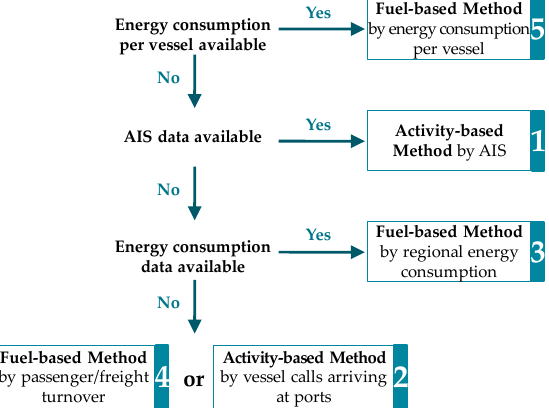
Figure 2. Methods recommended for large-scale inventory compilation.